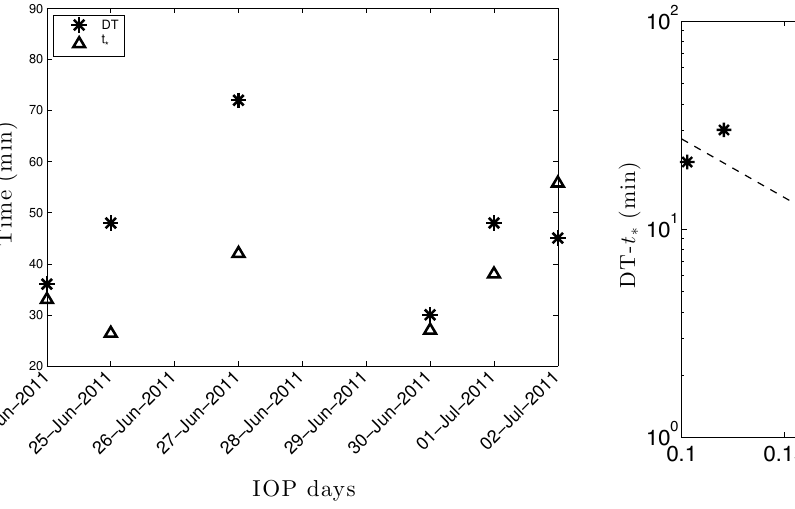
Figure 6. For each IOP, delay (asterisks) and convective (triangles) times.